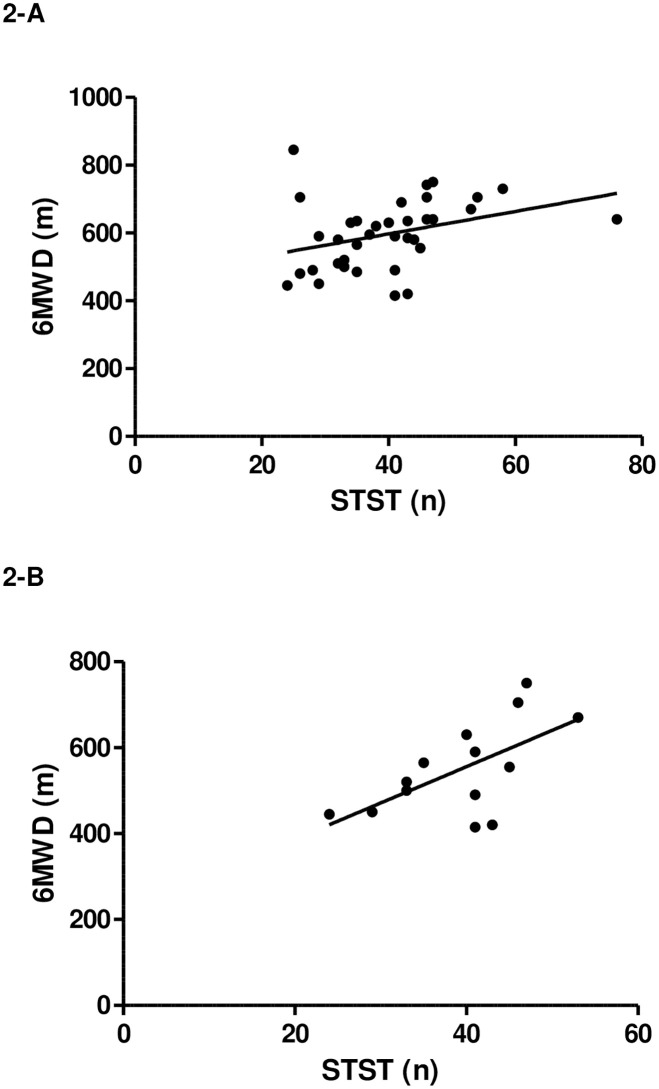
Relationship between the number (n) of movement repetitions performed during the STST and the distance (m) walked during the 6MWT; A: 36 children with CF aged 6 to 18 years (r = 0.48; p<0.01) and B: 14 children with CF aged 6 to 10 years (r = 0.54; p<0.05).